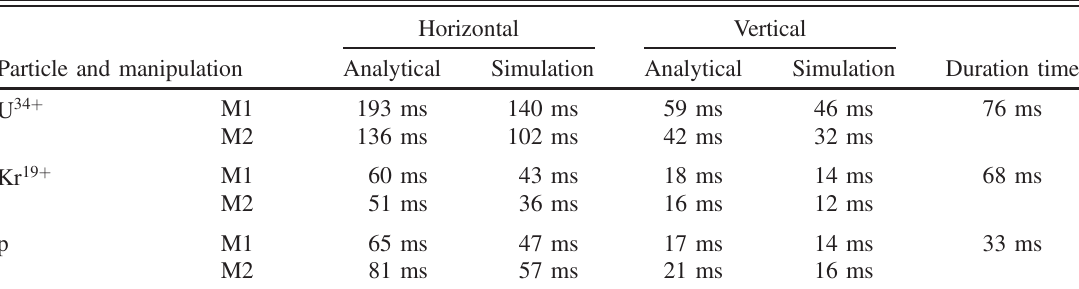
TABLE VI. Growth times of the transverse coupled-bunch instability in the M1 and M2. Horizontal Vertical Particle and manipulation Analytical Simulation